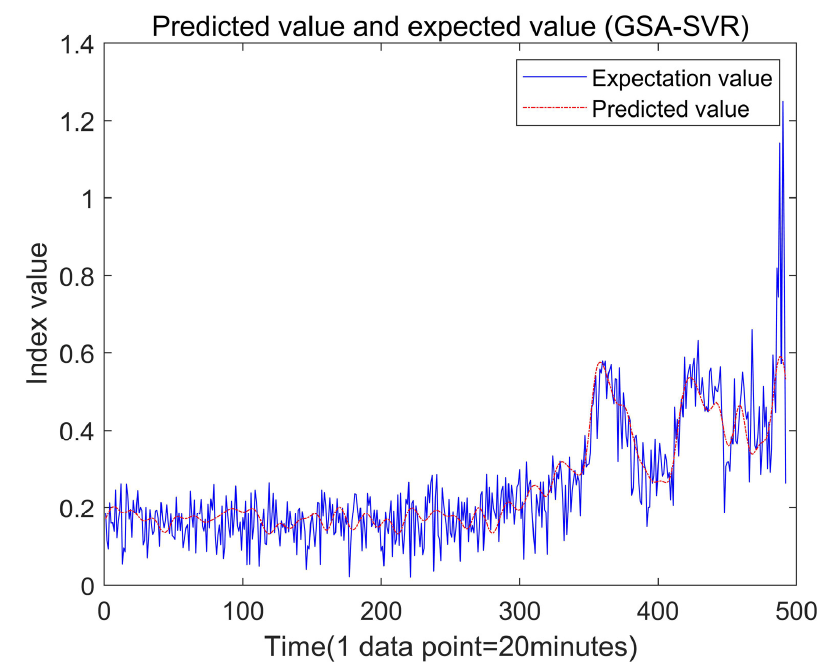
Figure 14. The regression prediction analysis of the test set by